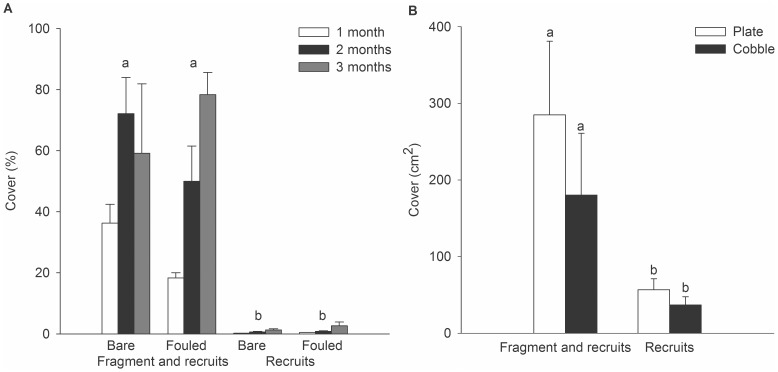
Establishment of Didemnum on different substrata.In two separate experiments of three months duration, different substrata were exposed to ambient larval recruitment, with half of them also inoculated with a Didemnum fragment. A) Mean Didemnum cover (% cover ±1SE) on bare settlement plates compared with plates that were pre-fouled with other sessile species. B). Mean Didemnum cover (cm2±1SE) on bare settlement plates compared with cobbles that were collected from the adjacent intertidal zone. In both experiments, substrata were suspended between 0.5 and 1.5 m deep. Different letters (a,b) indicate significant differences as indicated by the PERMANOVA post-hoc t-test.